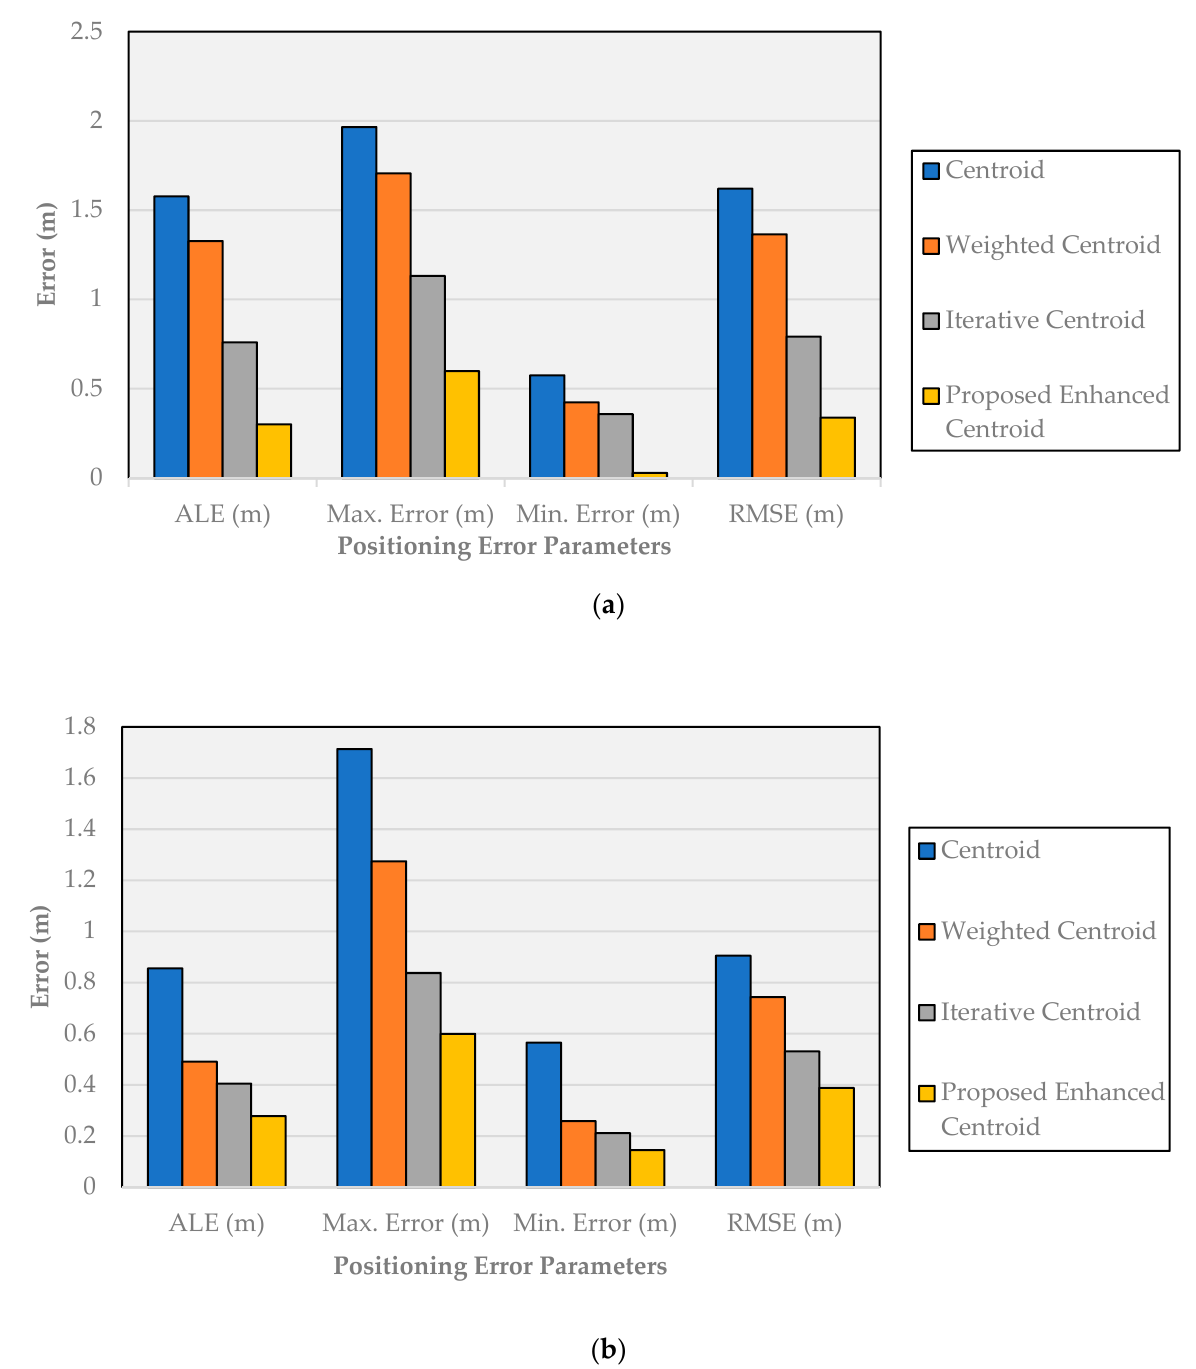
Figure 11. Positioning error parameters of different positioning algorithms: ( a ) The office room; ( b ) The corridor. As depicted in Figure 11a, the RMSE, maximum error, and minimum error values of the positioning results obtained by the enhanced centroid positioning algorithm based on the proposed RSSI distance prediction and correction model at the office room are lower than the other positioning algorithms. Moreover, the average localization errors of the four algorithms are 0.3, 0.76, 1.327 and 1.577 m, respectively, and the localization accuracy of the proposed enhanced centroid algorithm is improved by 80.97%, 77.39% and 60.526% compared with the centroid algorithm, the weighted centroid algorithm and the iterative centroid algorithm, respectively. As depicted in Figure 11b, the four algorithms’ average localization errors at the corridor are 0.278, 0.404, 0.491 and 0.855 m,